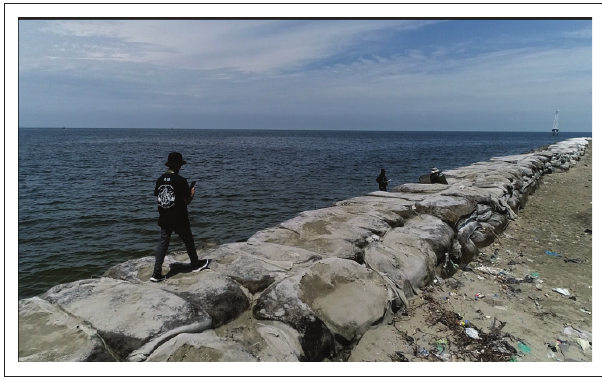
FIGURE 6: Construction of dams along the coastline.